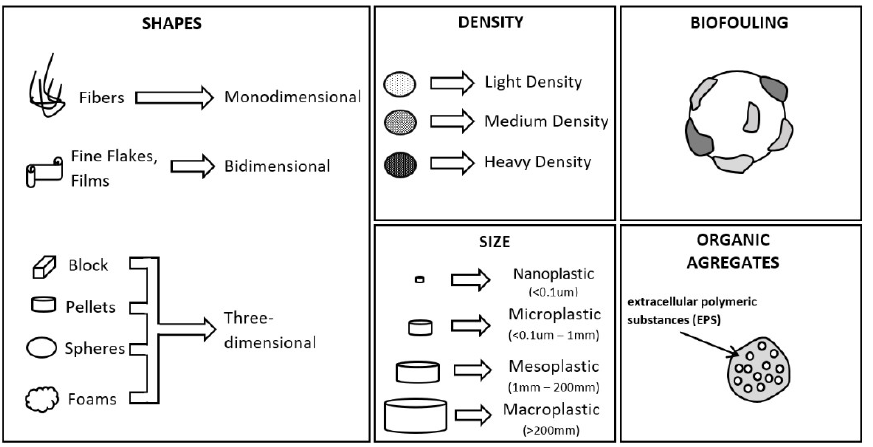
Figure 2. Characteristics of microplastics that influence their transport dynamics.